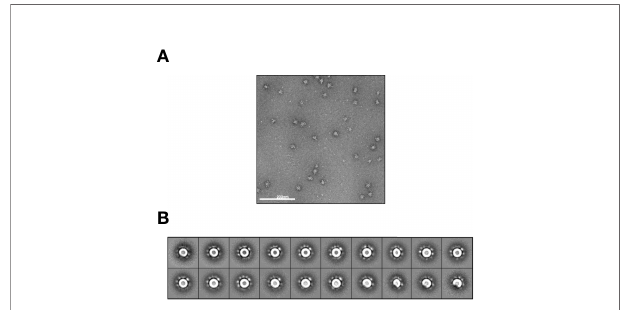
FIGURE 1 | NS-EM imaging of transiently expressed RBD-NP protein A sample of glycosylated RBD-NP protein: was applied to a carbon coated copper grid with uranyl-formate staining. Grids were prepared in duplicates and EM imaging was performed. (A) One of the 186 micrographs that were acquired. (B) 3271 particles were picked up manually and 2D-aligned into 20 classes. Nanoparticles are homogeneous in size, look as expected by the design with scattered RBD densities around the LS core and a diameter D ~30 nm. Distance between adjacent RBDs on spherical NP surface is calculated as ( p D 2 /60) 1/2 ~7